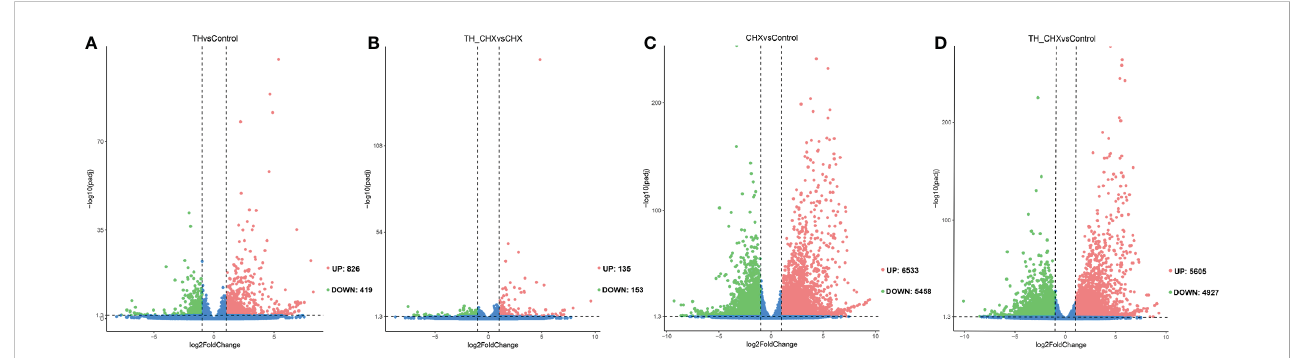
FIGURE 1 Volcano plots of differentially expressed transcripts (DETs) in the dorsal muscle for four pairwise comparisons. (A) TH vs. control. (B) TH_CHX vs. CHX. (C) CHX vs. control. (D) TH_CHX vs. control. The x-axis displays the log2 fold change value of the DETs, and the y-axis corresponds to the − log10 padj value of the DETs, with 0.05 set as the signi fi cance level cutoff. Upregulated DETs are shown in red; downregulated DETs are in green; non-signi fi cant DETs are presented in blue. TH, thyroid hormone; CHX,